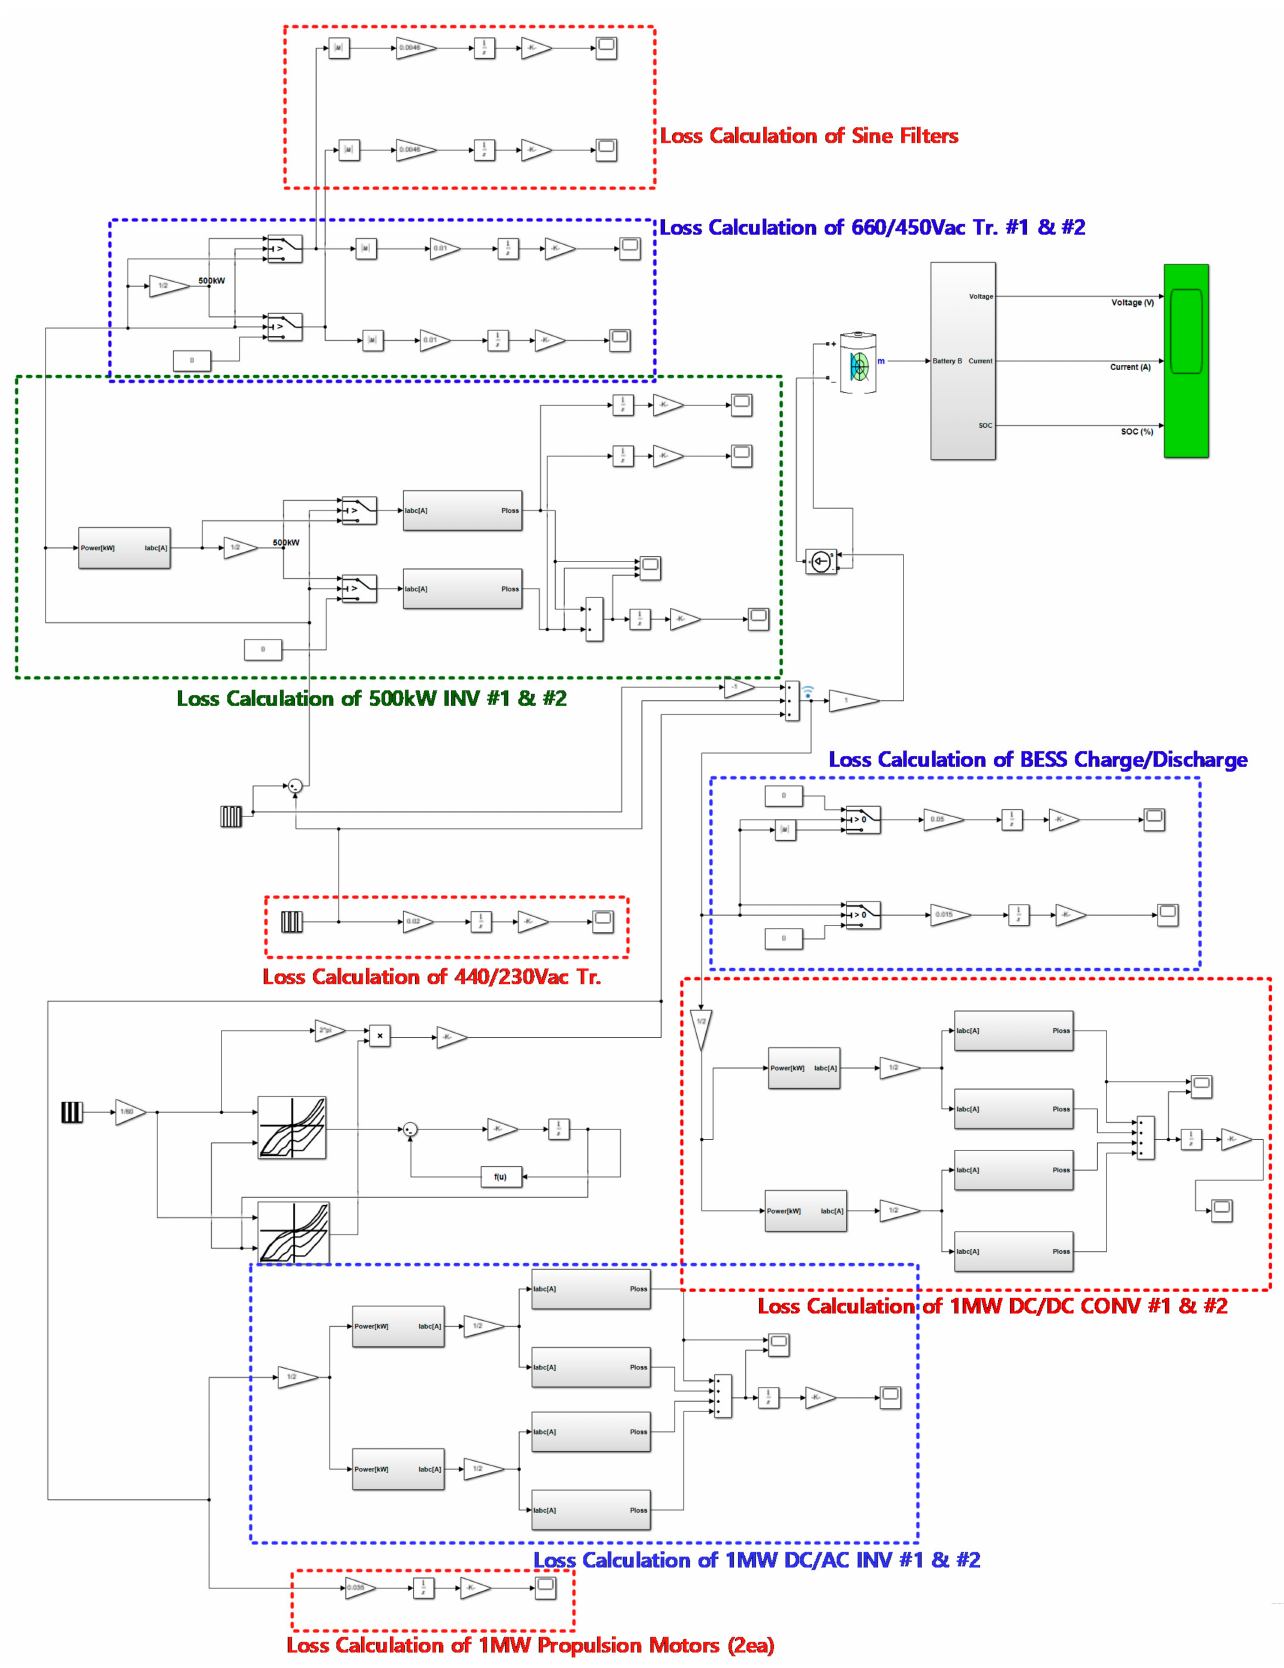
Figure 23. MATLAB/ SIMULINK model of the DC distribution